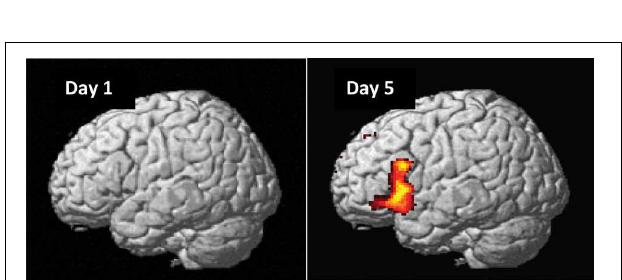
FIGURE 6 | Grammaticality effect during preference classification. Brain regions engaged by artificial syntactic anomalies (NG > G). Day 1: No significant effect in the left hemisphere ( P FWE > 0 . 50). Day 5: Significant activation in the inferior frontal (left and right: P FWE < 0 . 001) and medial prefrontal ( P FWE < 0 . 001; not shown)